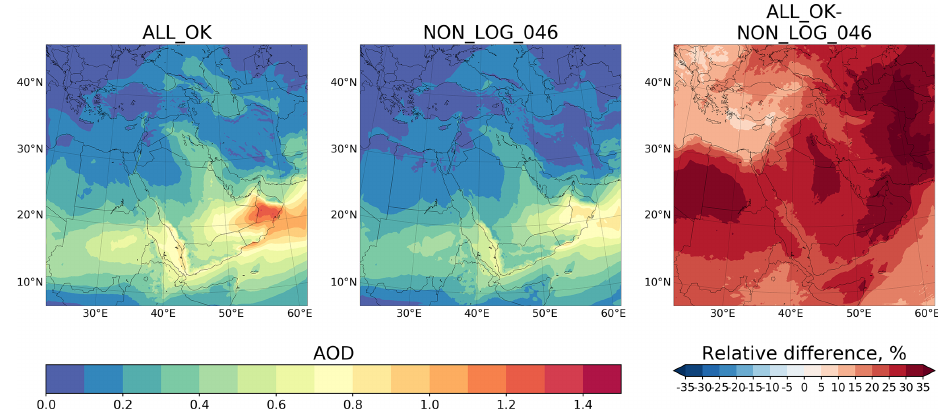
Figure 4. Averaged AOD fields obtained from the ALL_OK and NON_LOG_046 runs and their relative difference (%).